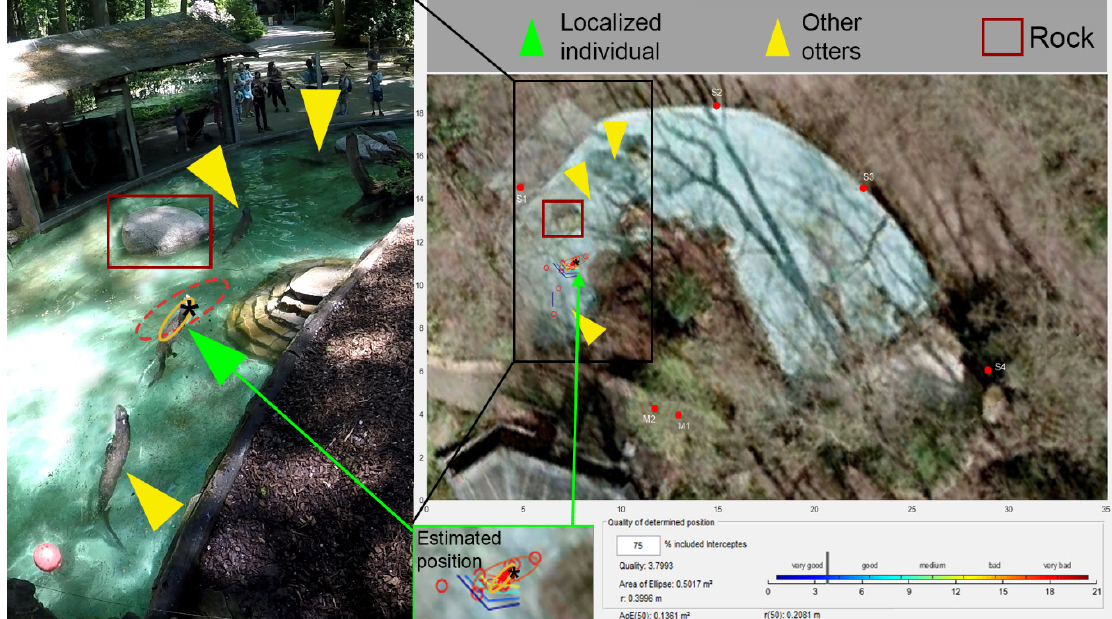
Figure 6. Example of sound localization using the software LASER in the giant otter enclosure. The left side of the figure shows the frame of the video recording at the time of the vocal utterance. The right side shows the result of the sound localization. The estimated position of the vocalizing animal is marked with a black asterisk. The area with the highest probability of location is enclosed with an orange ellipse (0.136 m 2 ), which contains 50% of the intersections of the hyperboloids. The red dashed ellipse contains 75% of the intersections of the hyperboloids. In the video frame the corresponding individual at this position is marked with a green arrowhead. The positions of the remaining otters are marked with yellow arrowheads on the map as well as in the video frame. For orientation, a rock in the water is outlined with a red